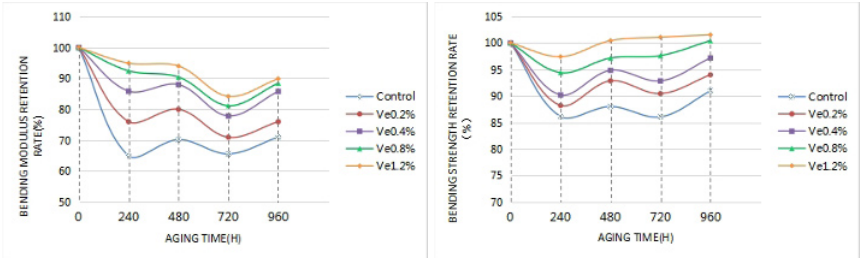
Fig. 2. The retention of bending strength of each group of Rice STRAW/PP WPC during